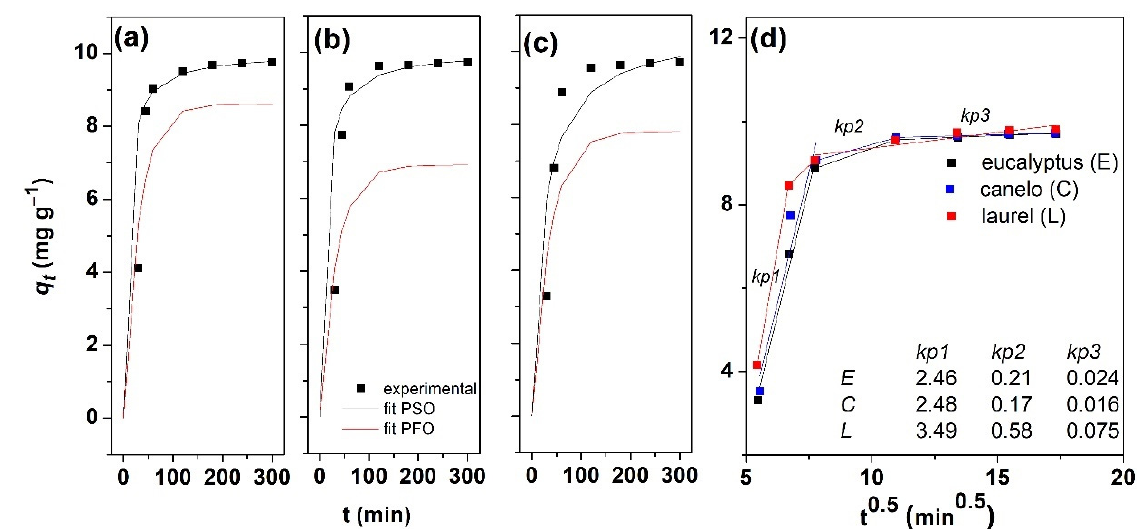
Figure 7. Adsorption kinetics of Zn on magnetite modified lignocellulosic waste-based adsorbents: laurel ( a ), canelo ( b ) and eucalyptus ( c ). Weber–Morris plot for intraparticle diffusion kinetics of Zn adsorption on magnetite eucalyptus modified adsorbent ( d ).